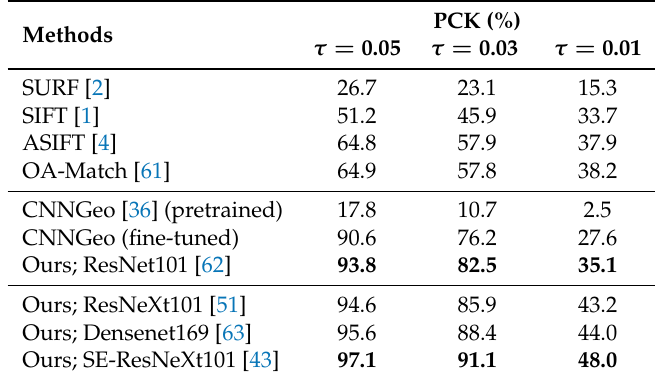
Table 1. Comparisons of probability of correct keypoints (PCK) in the aerial images. CNNGeo is evaluated in two versions: the pre-trained model provided in [36] and the fine-tuned model by the aerial images. Both models use ResNet101 as the backbone